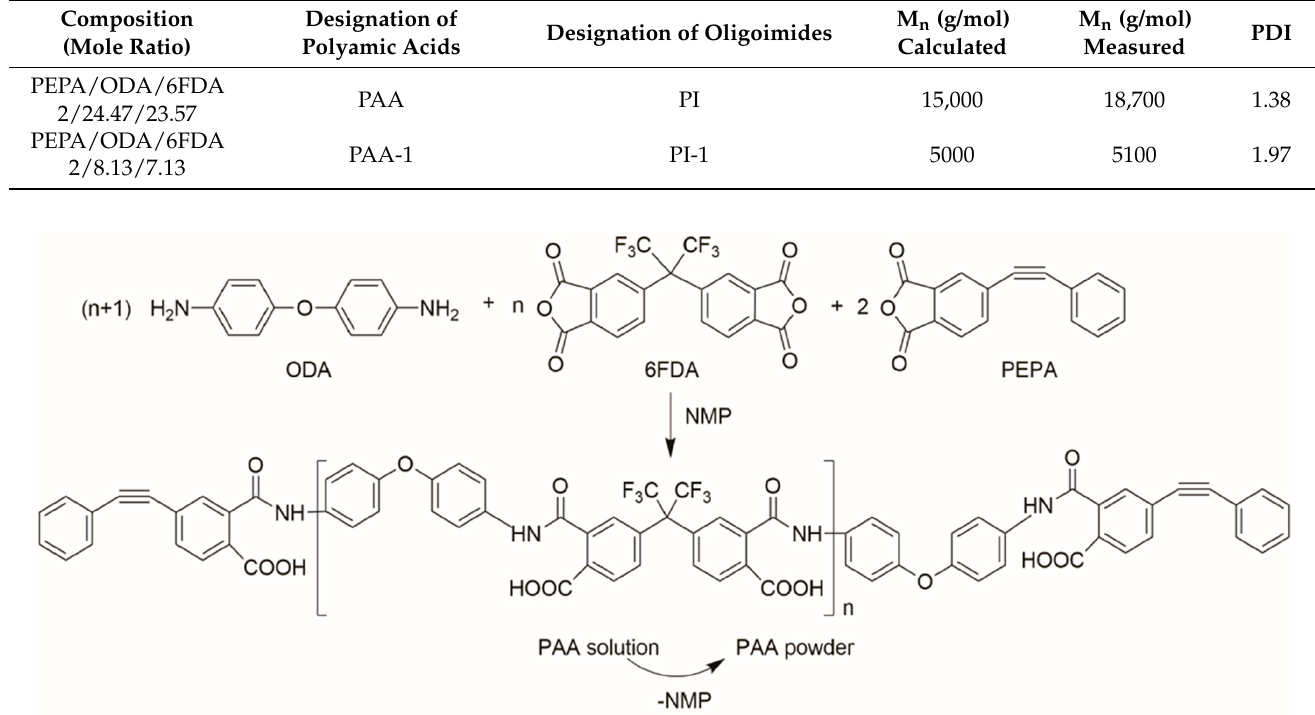
Figure 1. Schematic of the preparation of PAA powder.